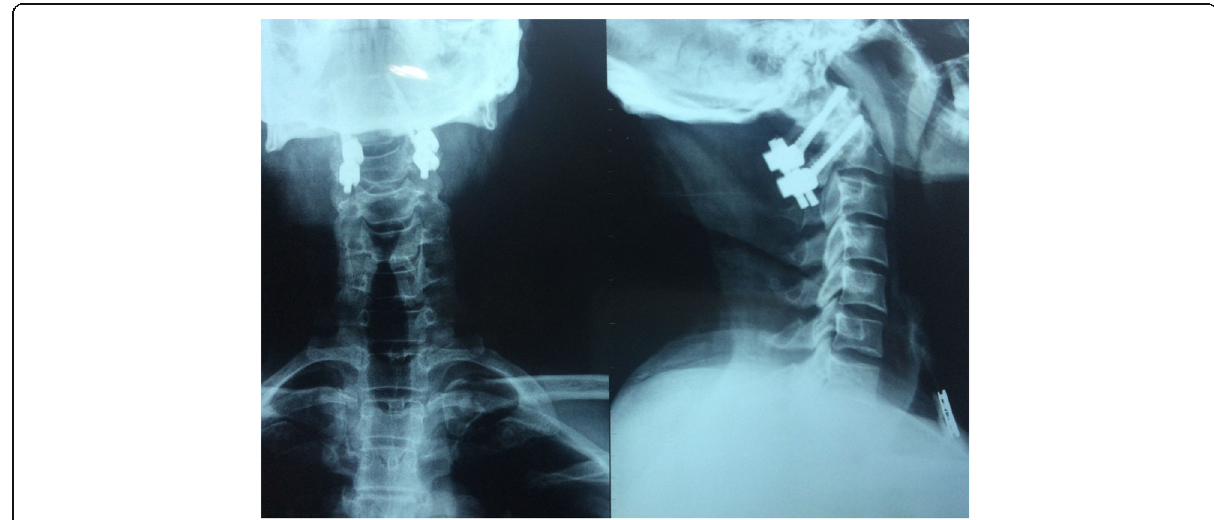
Fig. 7 Postoperative cervical spine